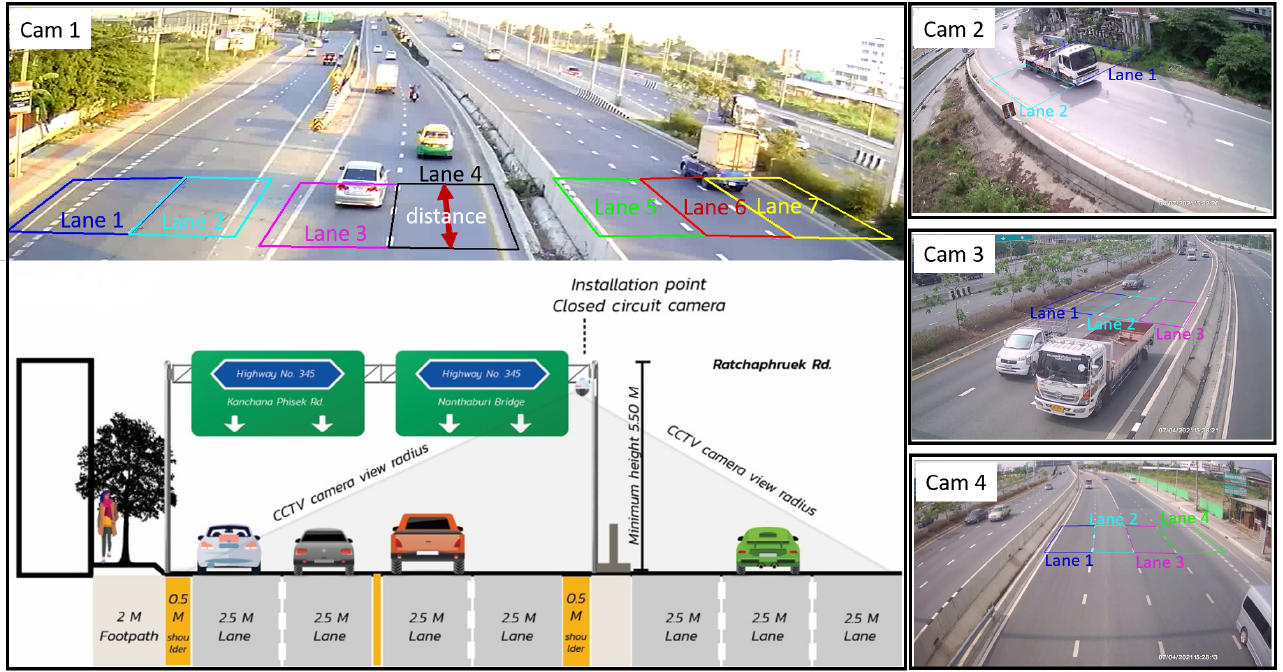
Figure 7. An experimental setup of four surveillance cameras for traffic monitoring. The lanes in the four streams are drawn as seen in their corresponding images (Cam 1, ..., Cam